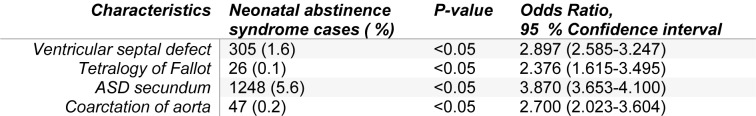
Characteristics of multiple cardiac defects in children with Neonatal abstinence syndrome